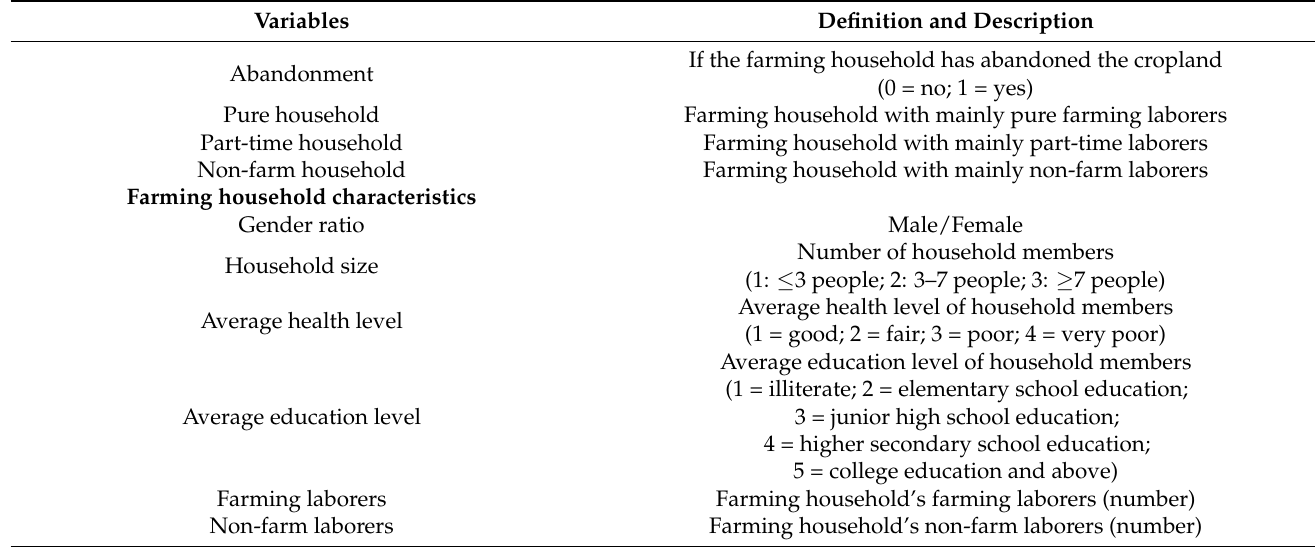
Table 1. Variable definitions and